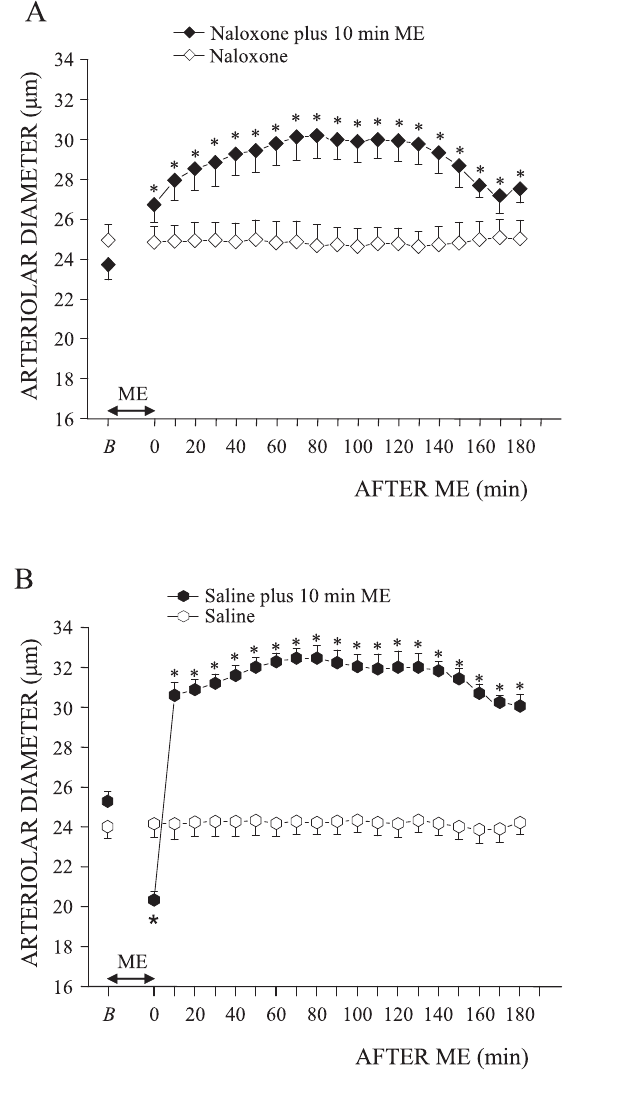
Fig. 4. Nociceptors inhibition with naloxone abolished the vasocostriction during 10 minutes ME. (A) Naloxone was administered as described in Fig. 1B. Naloxone alone did not modify the diameter of order 2 arterioles (n 5 4 rats, open rhomb), while, when associated with ME, it suppressed (n 5 4 rats, filled rhomb) the constriction observed during ME, but did not affect the dilation observed after ME. (B) Saline administration (see Fig. 2B) did not influence the ME effects on pial arterioles diameter (n 5 4 rats, filled hexagon), while, when applied alone, (n 5 4 rats) it did not induce any changes in pial arterioles diameter (open hexagon). * Significantly different from the baseline